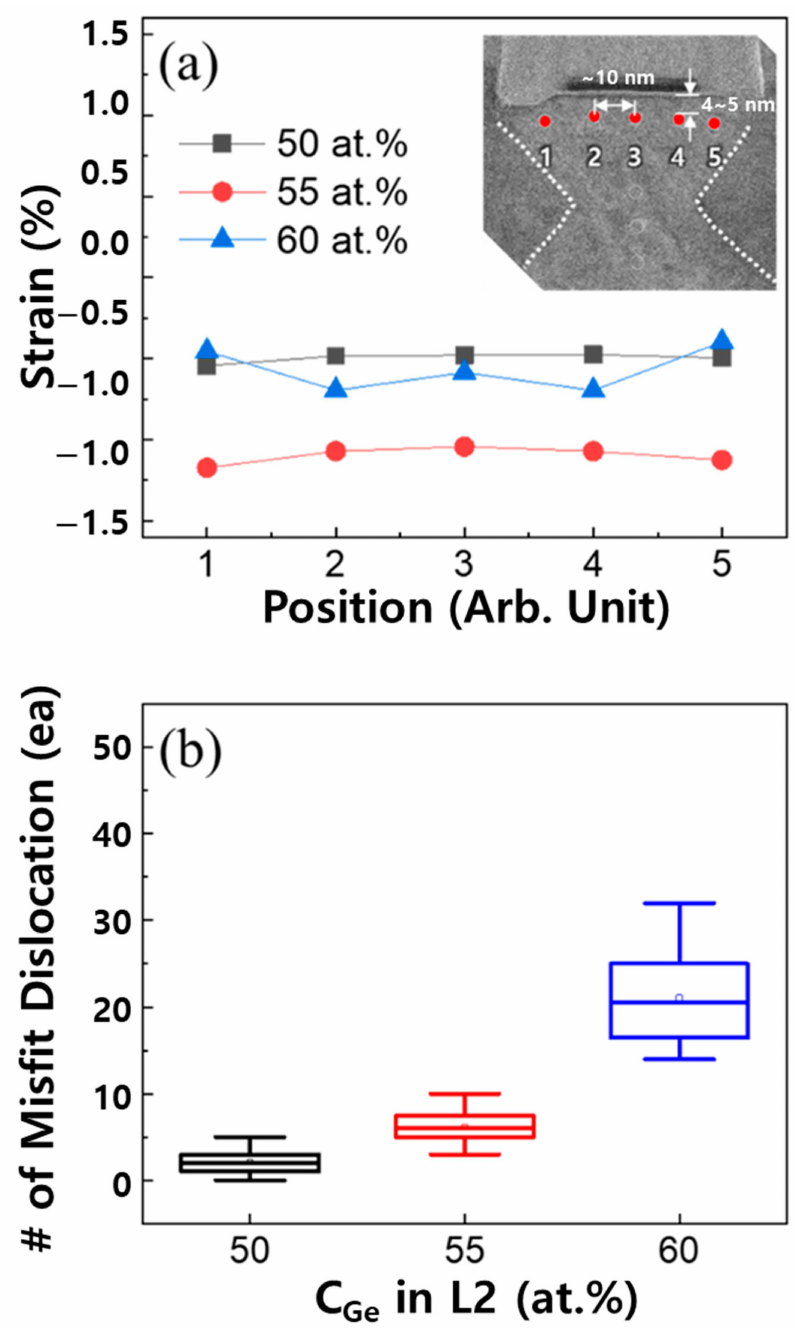
Figure 4. ( a ) Strain distributions measured for various C Ge in SiGe of L2 by NBD analysis and ( b ) the number of misfit dislocation included in L2 (counted for 100 sigma cavities and statisti- cally